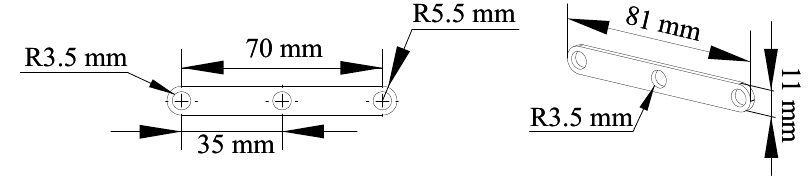
Figure 9. Drawing of stretchable slices structure.